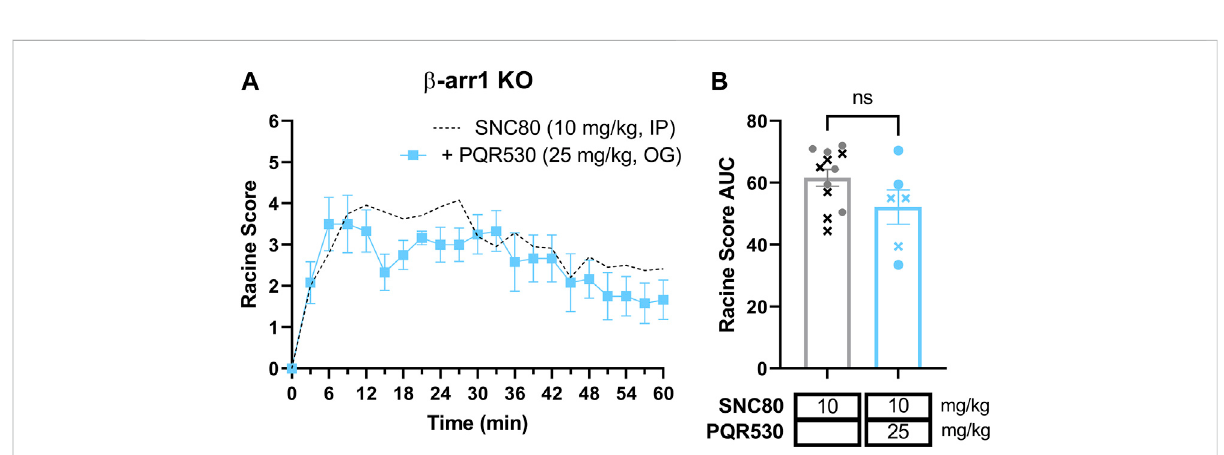
FIGURE 7 ThePI3KandmTORinhibitorPQR530doesnotinhibitSNC80-inducedseizuresin β -arrestin1knockoutmice.Seizureactivityovertime (A)